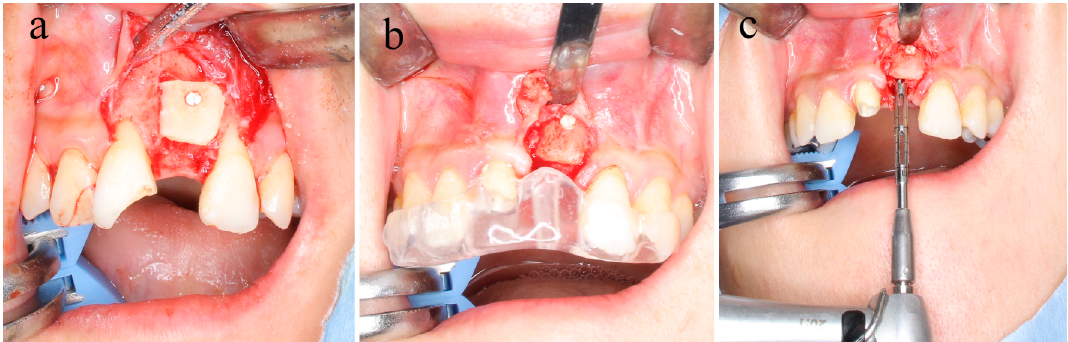
Figure 1. ( a ) In the surgical operation, the amount necessary for bone augmentation was collected from the buccal cortical bone block of the mandibular ramus, and the buccal cortical bone block was fixed to the recipient site with uncalcined and unsintered hydroxyapatite/poly-l-lactide (u-HA/PLLA) screws. ( b , c ) Six months later, dental implantation surgery was planned. The position of the u- HA/PLLA screw was confirmed. At the time of implant placement, specimens were collected using a 2.0 mm diameter trephine